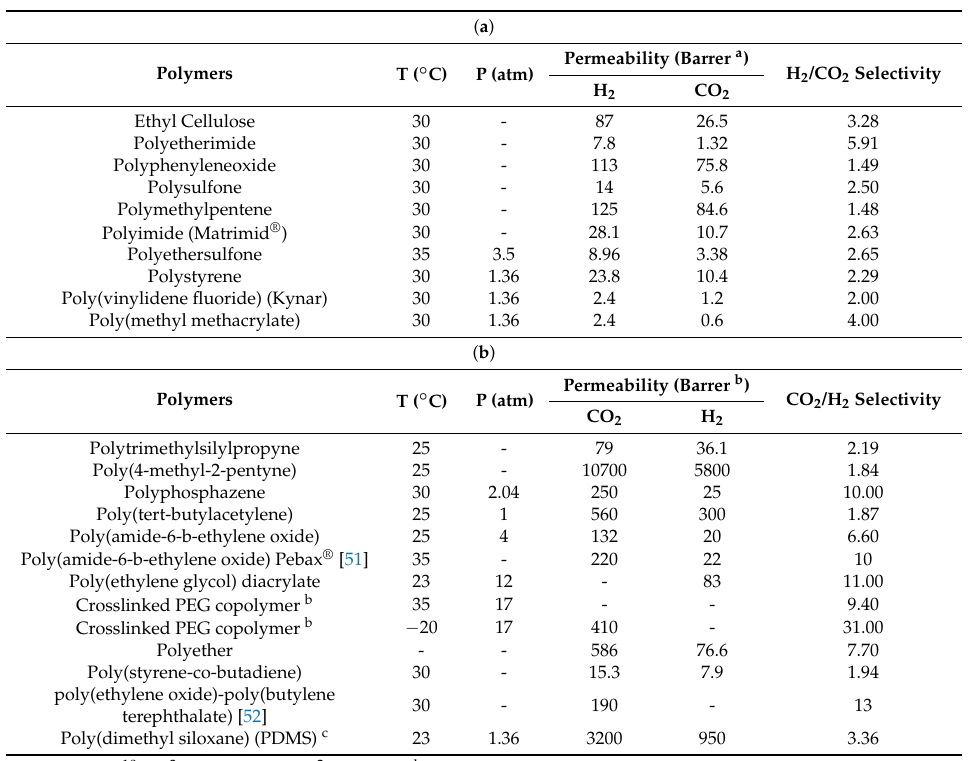
pressure of CO 2 is 17 atm; c Data obtained from synthetic syngas mixture.